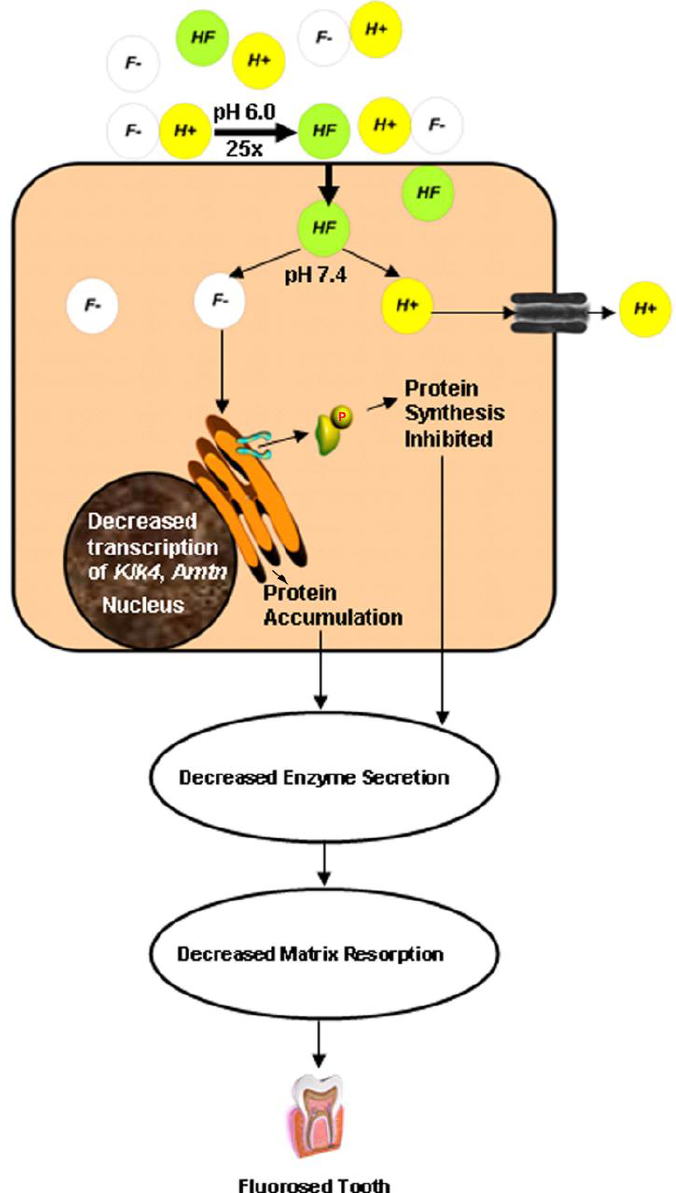
Figure 1. Schematic showing a postulated mechanism for maturation stage ameloblast sensitivity to fluoride. During the maturation stage, massive precipitation of hydroxyapatite occurs, releasing H + ions. F - can reversibly associate with H + ions to form HF. Approximately 25-fold more HF is formed at pH 6.0 as compared to pH 7.4. HF diffuses into the cell more easily than F - and flows down a steep concentration gradient from the acidic maturation stage enamel matrix into the neutral cytosol of the ameloblast. The neutral pH inside the cell causes reversion of HF to F - . Excess F - within the cell interferes with ER homoestasis that may result in the dimerization and phosphorylation of PERK and its substr (cid:68)(cid:87)(cid:72)(cid:15)(cid:3) (cid:72)(cid:44)(cid:41)(cid:21)(cid:302)(cid:17)(cid:3) (cid:38)(cid:82)(cid:81)(cid:86)(cid:72)(cid:84)(cid:88)(cid:72)(cid:81)(cid:87)(cid:79)(cid:92)(cid:15)(cid:3) (cid:83)(cid:85)(cid:82)(cid:87)(cid:72)(cid:76)(cid:81)(cid:3) (cid:86)(cid:92)(cid:81)(cid:87)(cid:75)(cid:72)(cid:86)(cid:76)(cid:86)(cid:3) (cid:76)(cid:86)(cid:3) (cid:68)(cid:87)(cid:87)(cid:72)(cid:81)(cid:88)(cid:68)(cid:87)(cid:72)(cid:71)(cid:17)(cid:3) (cid:40)(cid:53)(cid:3) (cid:86)(cid:87)(cid:85)(cid:72)(cid:86)(cid:86)(cid:3) (cid:70)(cid:68)(cid:81)(cid:3) (cid:68)(cid:79)(cid:86)(cid:82)(cid:3) (cid:79)(cid:72)(cid:68)(cid:71)(cid:3) (cid:87)(cid:82)(cid:3) increased degradation of transcripts encoding secreted proteins such as KLK4. Collectively, decreased secretion of matrix-degrading enzymes such as KLK4 can lead to delayed resorption of enamel matrix proteins, resulting in the higher protein content observed in fluorosed enamel. ER, endoplasmic reticulum. Reproduced with permission from